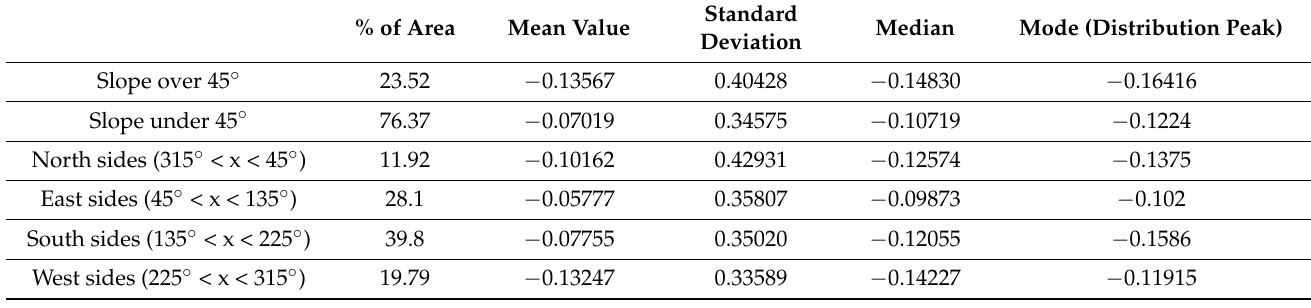
Table 2. Quantity (%) of study area occupied by pixel values and the statistical parameters computed for the pixel distributions of the six rasters processed according to the slopes and exposures of biancane hillsides.